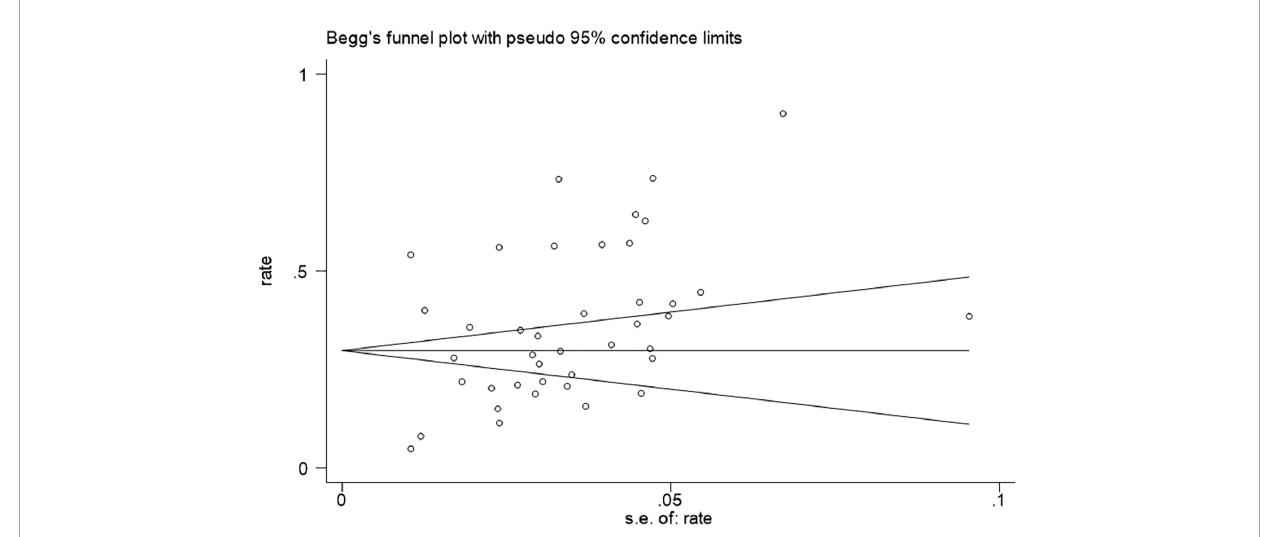
FIGURE7 Funnel plot of meta-analysis on prevalence of anxiety in MS